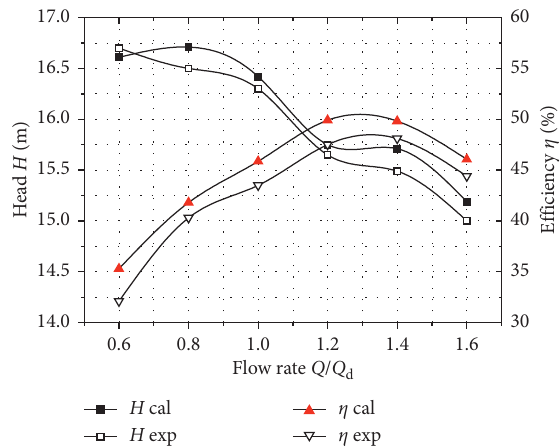
Figure 4: Comparison of calculation and